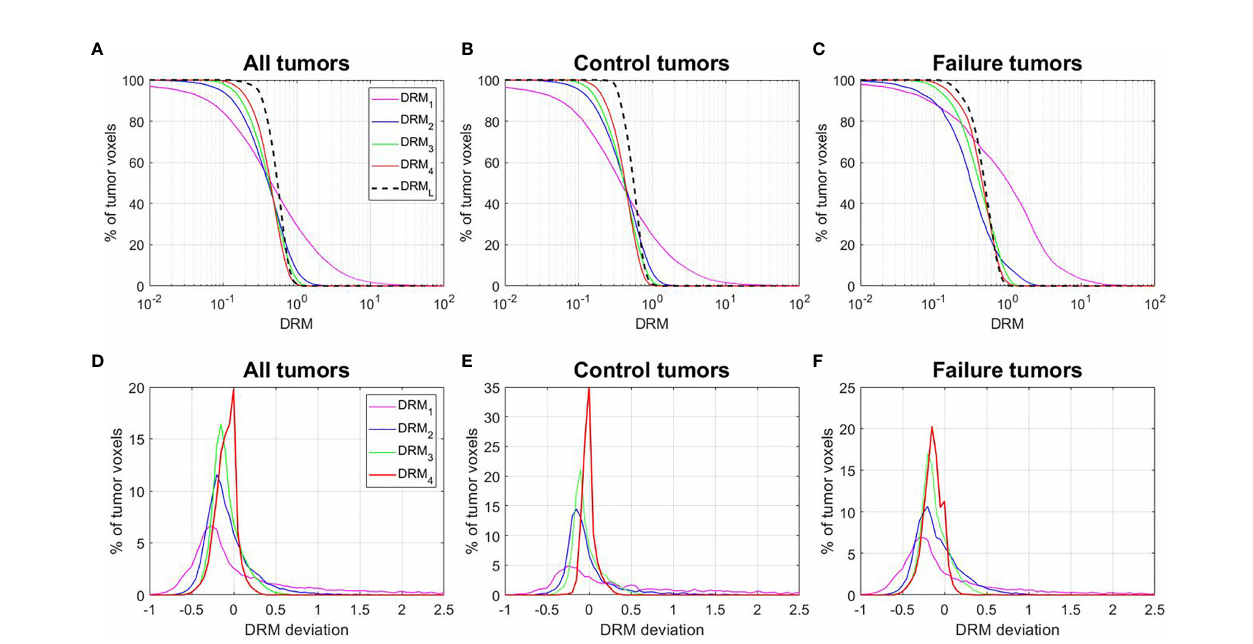
FIGURE 6 | (A – C) Cumulative histograms of the dose – response matrix (DRM) for all tumors, control tumors, and failure tumors. (D – F) Histograms of the DRM deviations = DRM i − DRM L . DRM i = DRM estimated using the feedback image acquired at the i th treatment week; DRM L = DRM estimated using the last treatment week feedback image.